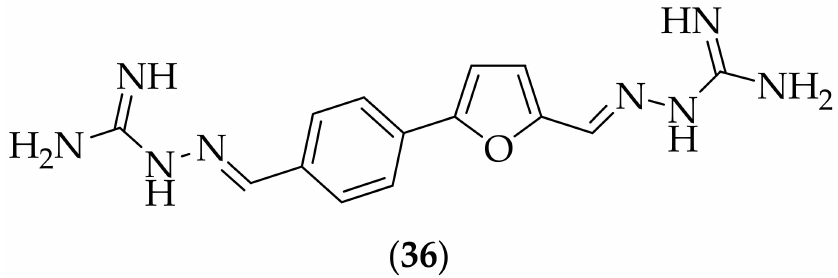
Figure 22. Furan-based bis-guanylhydrazone antifungal derivative ( 36 ). In 2016 a set of thirteen guanidine -containing benzothiazole analogs were synthesized and tested by Bhat and Belagali, [51]. The compounds were tested at 200 µ g/mL for their zone of inhibition of Candida albicans and Aspergillus niger , and the two most interesting compounds were ( 37 ) and ( 38 ), Figure 23. ( 37 ) and ( 38 ) produced zones of inhibition for Candida albicans of 40 and 41 mm, respectively, and for Aspergillus niger the zones of inhibition were lower, 21 and 25 mm respectively. The MIC values for Candida albicans and Aspergillus niger were also calculated- for Candida albicans the MIC values were 3.125 µ